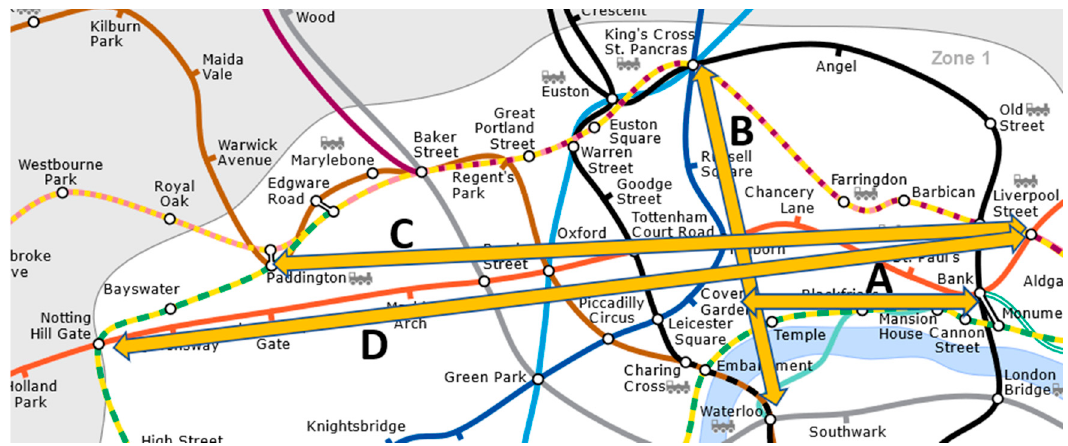
Figure 15. Routes under consideration for analyzing transport modes in Central London.